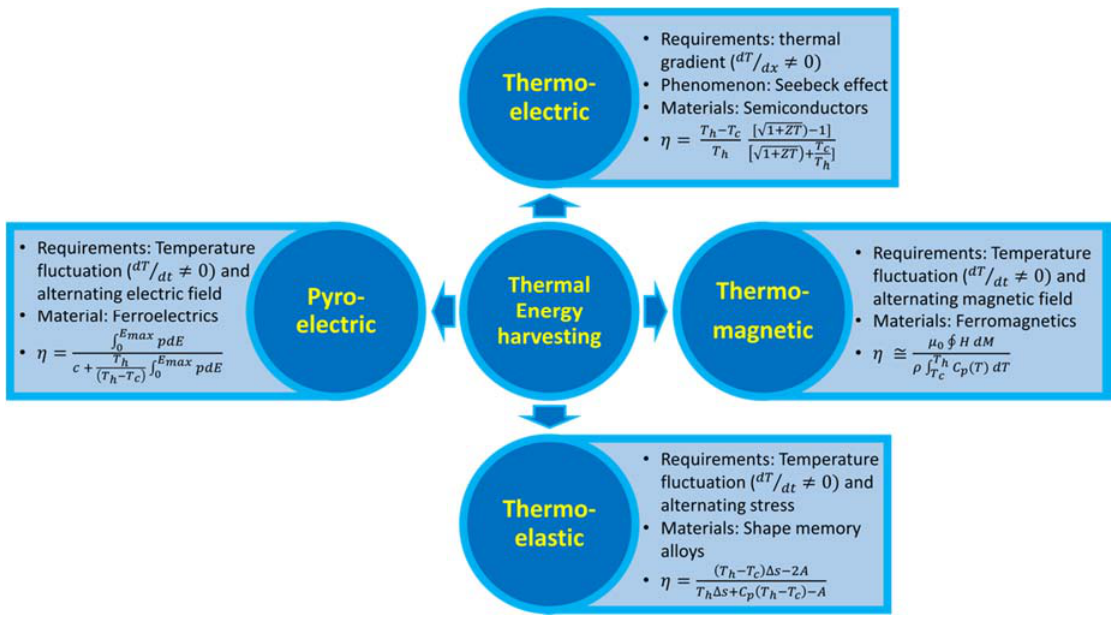
Figure 1. Relevant thermal energy harvesting technologies: thermoelectricity, pyroelectricity, thermomagneticity, and thermoelasticity. Thermal energy harvesters are solid-state devices that do not require any fuel and do not produce harmful discharge.